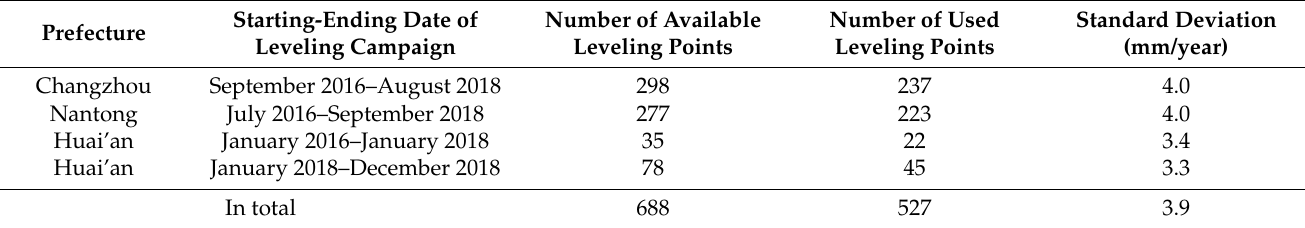
Table 2. Information on leveling points and